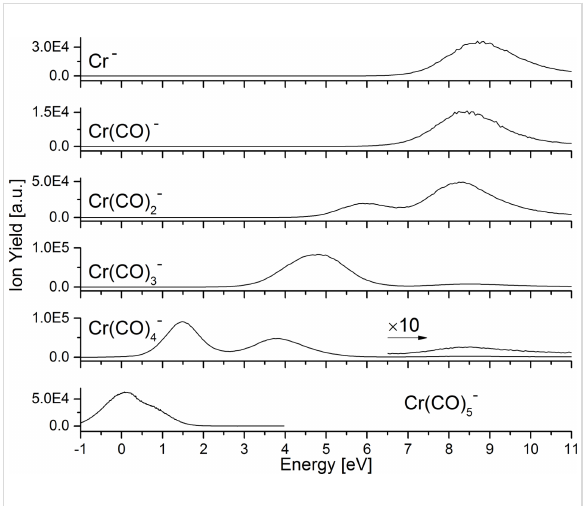
Figure 1: Ion yield curves of negatively charged fragments formed by dissociative electron attachment to chromium hexacarbonyl, Cr(CO) 6